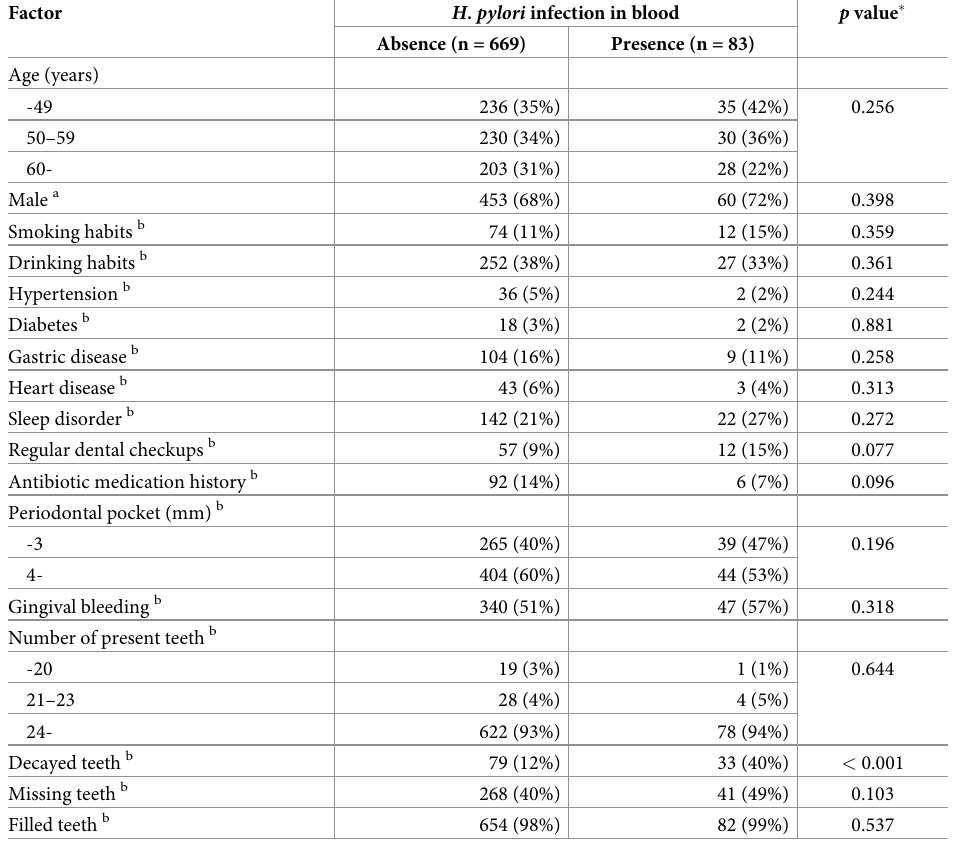
� p < 0.05, using the Fishers exact test or the Mann-Whitney U test. a Male (proportion of male) b presence (proportion of